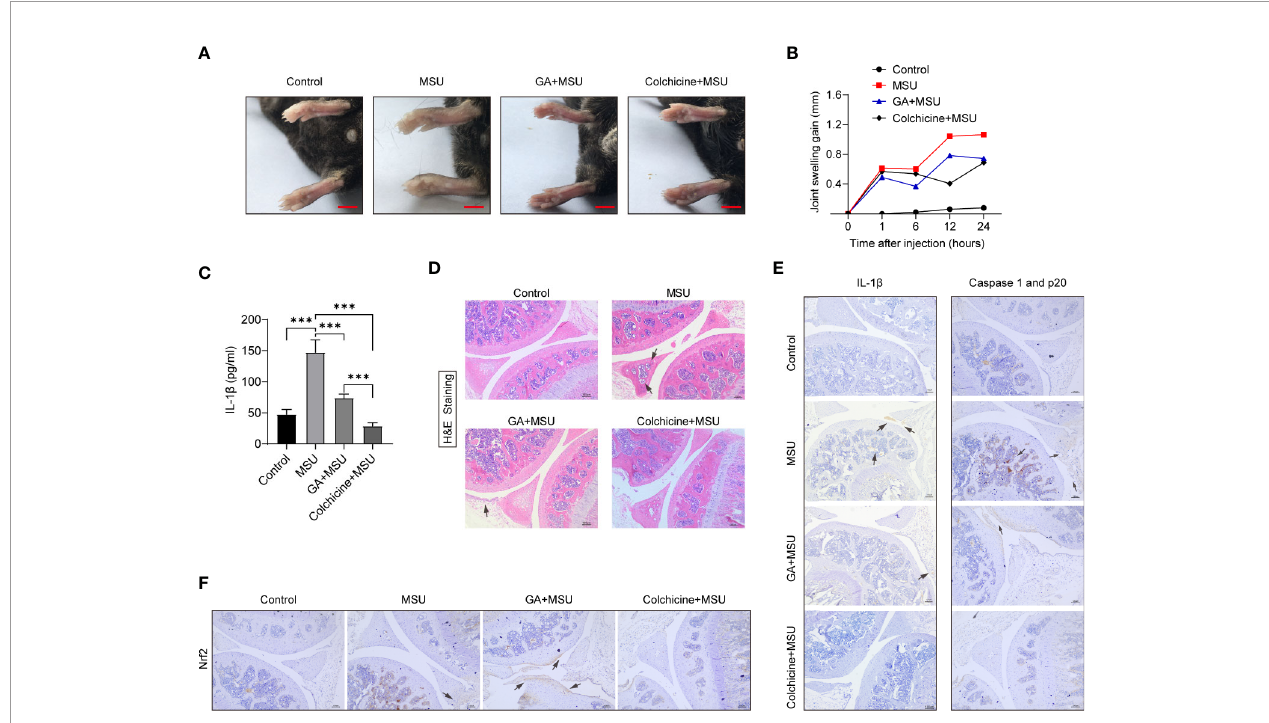
FIGURE 6 | Gallic acid alleviates monosodium urate (MSU)-induced NLRP3 in fl ammasome activation in vivo . (A – D) C57BL/6J mice were treated with an intra- articular injection of MSU crystals (1 mg/mouse) in the presence of gallic acid (100 mg/kg) or colchicine (1 mg/kg) for 24 h. Representative ankle photographs were shown in (A) , Scale bars, 3.5 mm. (B) Joint swelling was measured at different time points. (C) Joint culture supernatant medium was measured by the IL-1 b ELISA kit. Data are shown as means ± sem ( n = 6 mice). (D) Hematoxylin and eosin (H&E)-stained in fi ltrated leukocytes (black arrow) in joint tissues. (E, F) Immunohistochemical of IL-1 b , caspase 1 p20, and Nrf2 were acquired in the indicated groups. Scale bars, 100 m m. GA, gallic acid. *** P <